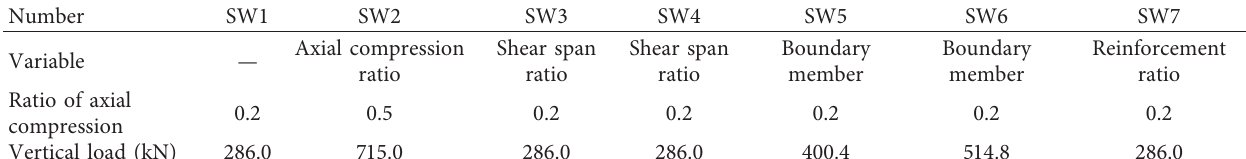
Table 2: Value of vertical load.